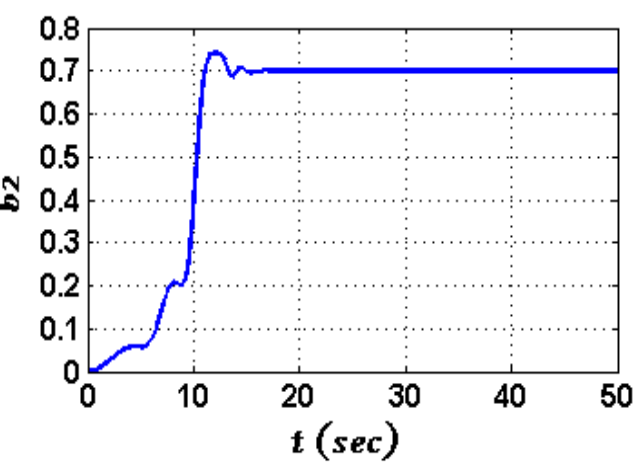
Figure 5 . Synchronization errors. Figure 5. Synchronization errors.